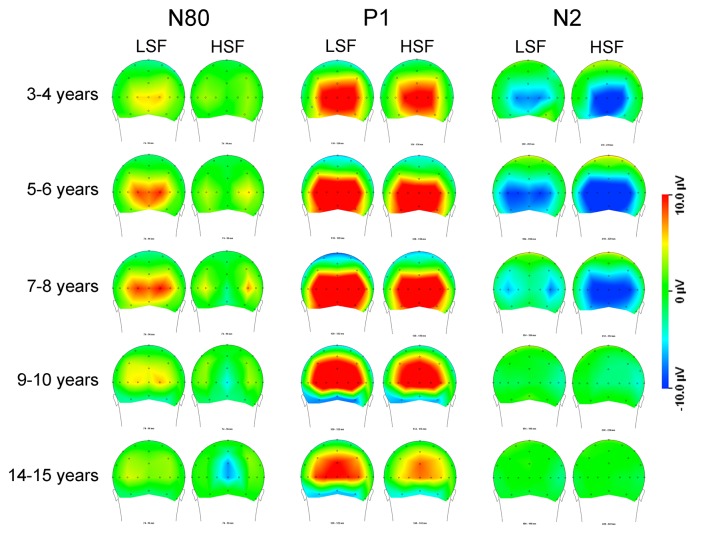
Topographical representations of brain activity, evoked by LSF (global) or HSF (detailed) stimuli at the moment of the N80, P1, and visual N2 peaks.